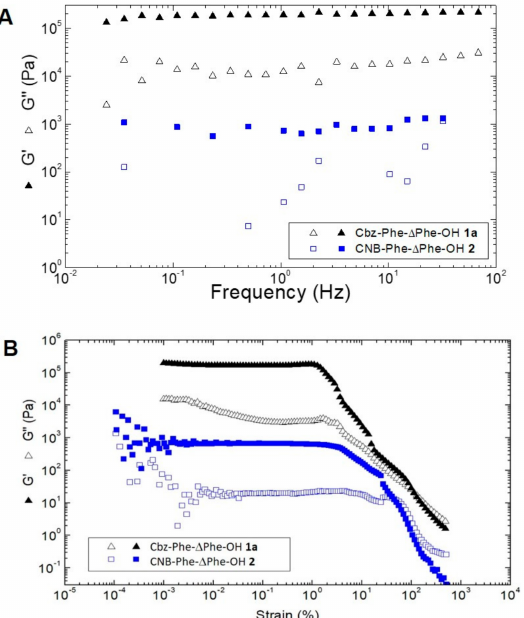
Figure 5. ( A ): Frequency dependence of the shear elastic G (cid:48) (empty symbols) and loss G (cid:48)(cid:48) (filled symbols) moduli for hydrogels formulated at 0.4 wt.% of hydrogelator 2 (squares) and 1a (triangles). ( B ): Strain dependence of the shear elastic G’ and loss G” moduli for hydrogels formulated at 0.4 wt.% of hydrogelator 1a (black) and 2